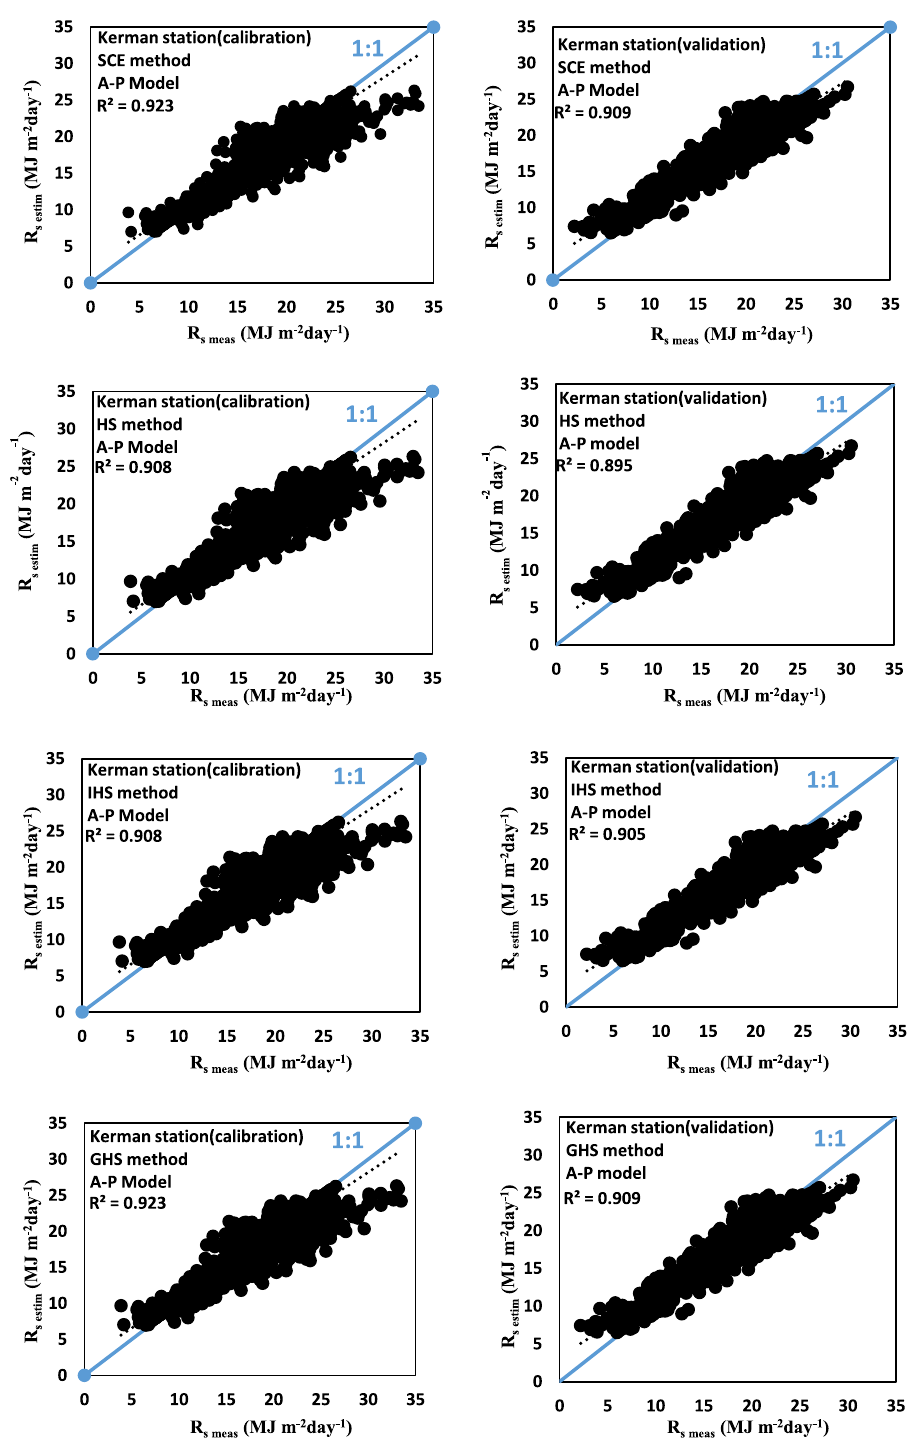
Figure 2. Comparison of measured and estimated Rs in the A–P